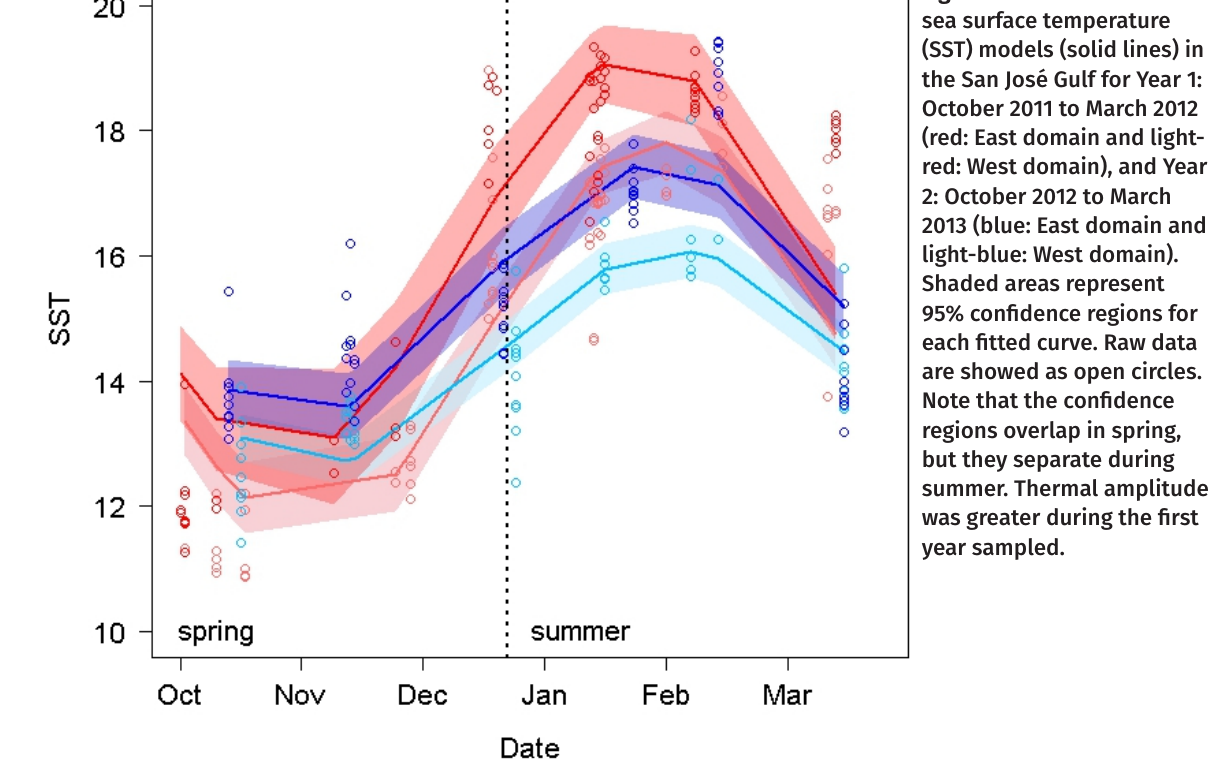
Figure 2. Sinusoidal satellite sea surface temperature (SST) models (solid lines) in the San José Gulf for Year 1: